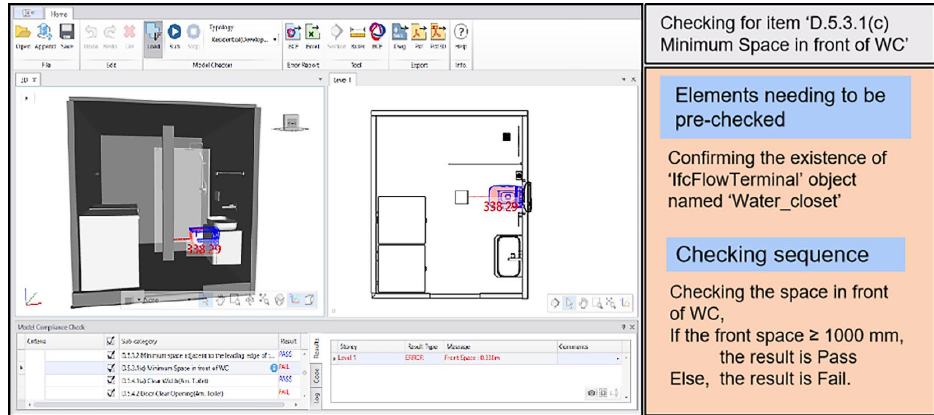
Figure 10. Example of checking item “D.5.3.1(c) Minimum Space in front of